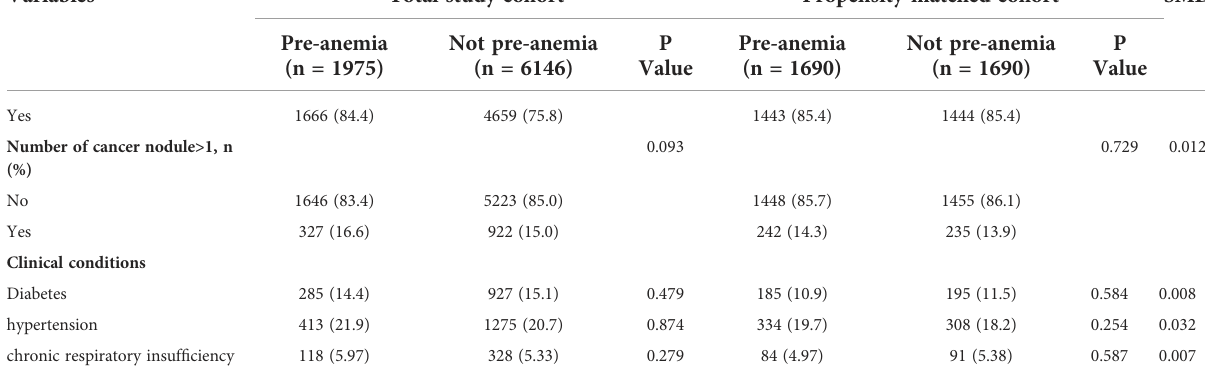
Figure 3A). Meanwhile, patients who were not anemic before